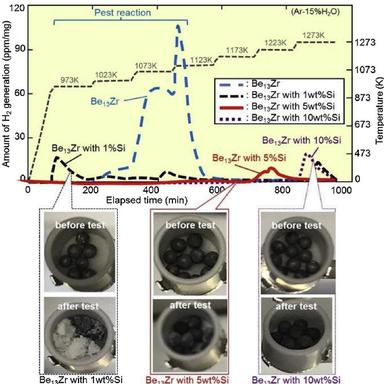
Hydrogen generation amount of the Be13Zr pebbles with 1, 5, and 10 wt.% of Si compared to the as-granulated Be13Zr pebbles, and photographs of specimens before and after the test.